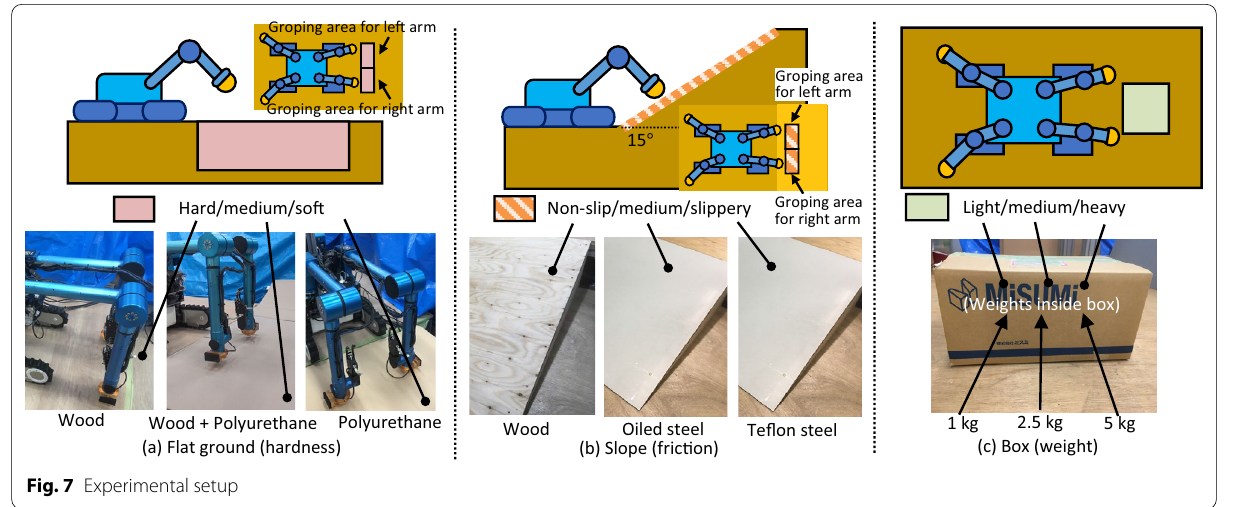
Fig. 7 Experimental setup